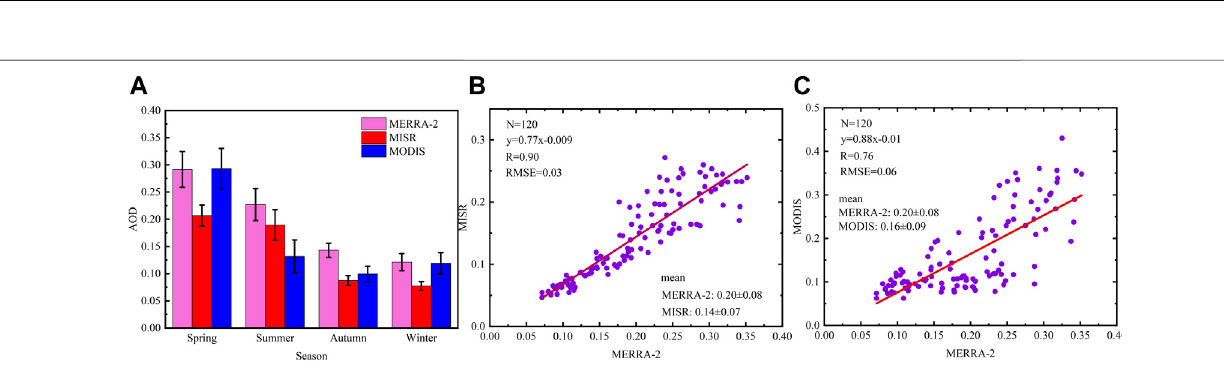
FIGURE 1 | Monthly variations in the TP AOD from the (A) MERRA-2, (B) MODIS, and (C) MISR retrievals during 2009 – 2018 and spatial distributions of the averagedAODovertheTPfromthe (D) MERRA-2, (E) MODIS,and (F) MISRretrievalsduring2009 – 2018.Notethattheerrorbarsrepresentthestandarddeviationofthe corresponding variables.